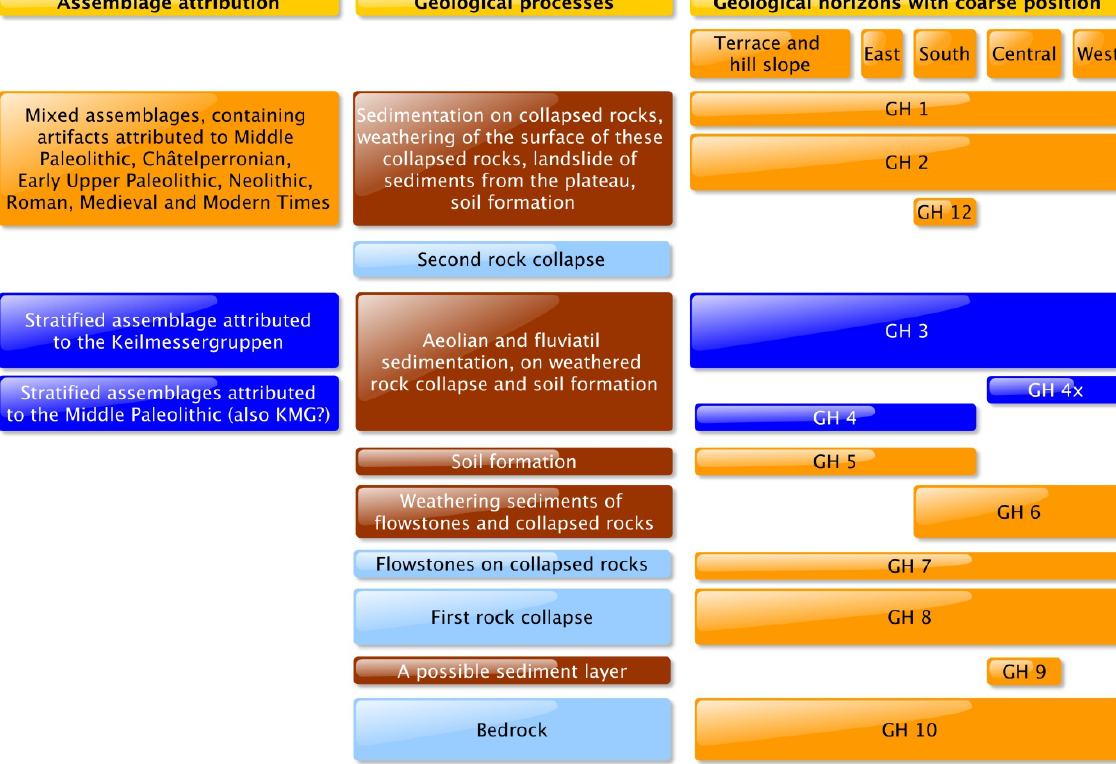
Figure 2. Synthesized stratigraphic sequence of VP II, divided into assemblage attribution, geological processes and defined geological horizons. (Image created using the free software yED from